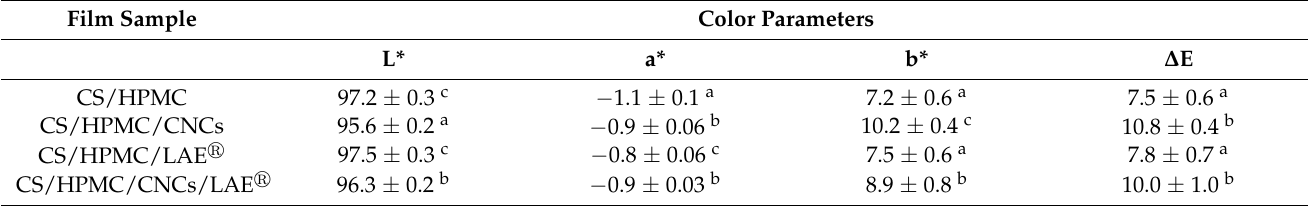
Table 3. Color parameters (L*, a*, and b*) and total color variation ( ∆ E*) of films based on chi- tosan/hydroxypropyl methylcellulose blend (CS/HPMC) as control and those reinforced with cel- lulose nanocrystals (CNCs 10% ( w / w ) of biopolymer) and/or enriched with lauroyl arginate ethyl (cid:114) (LAE 5% w / w of polymer).